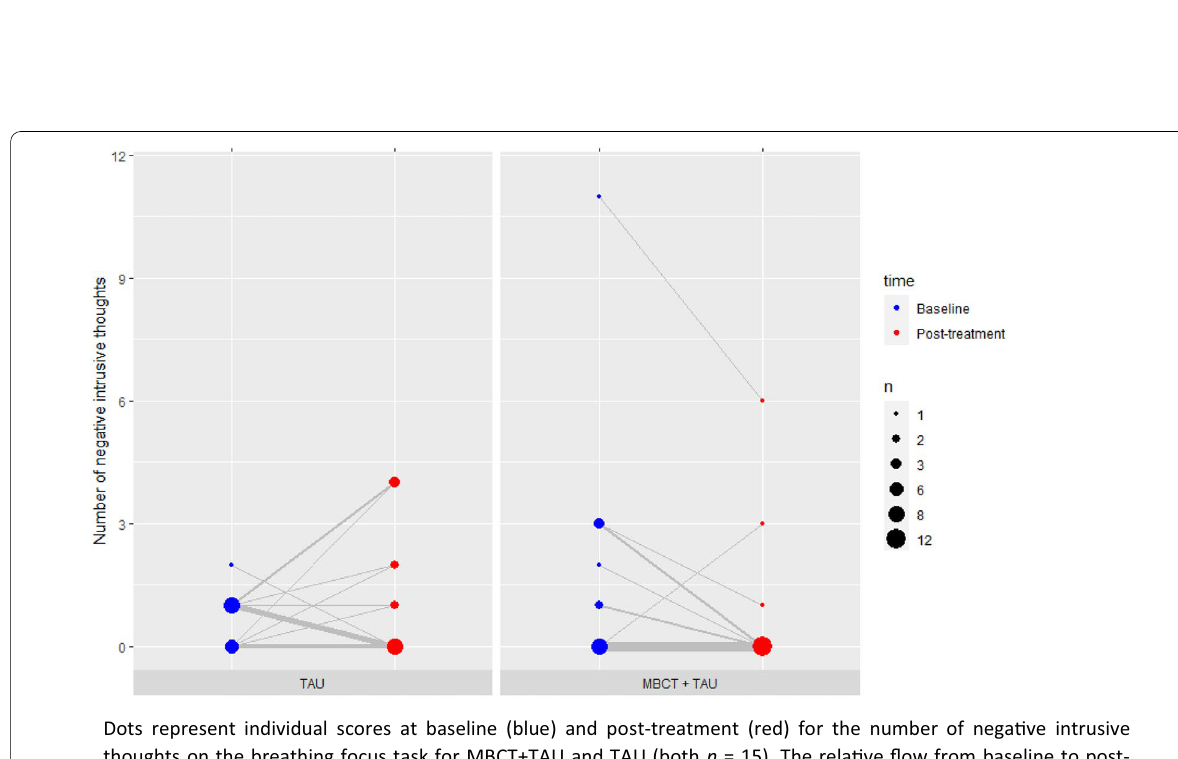
Dots represent individual scores at baseline (blue) and post-treatment (red) for the number of nega(cid:7)ve intrusive thoughts on the breathing focus task for MBCT+TAU and TAU (both n = 15). The rela(cid:7)ve flow from baseline to post- treatment is indicated by the thickness of the connec(cid:7)ng lines. MBCT = Mindfulness-based Cogni(cid:7)ve Therapy, TAU = treatment as usual. Fig. 2 Effect of mindfulness‑based cognitive therapy on negative intrusive thoughts over